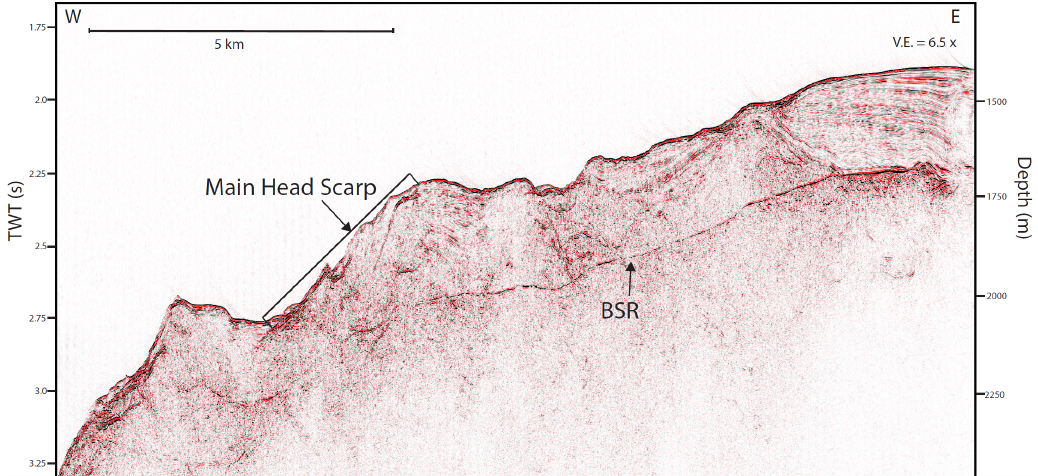
Figure 3. ( A ) Eastern half of seismic line 15 from RR1718 uninterpreted. ( B ) Eastern half of seismic line 15 interpreted. Green lines represent reverse faults and gray vertical dotted lines indicate fluid pathways. Horizontal dashed lines represent inferred layers and boundaries. The base of the landslide blocks is also an inferred boundary. ( C ) Map view of area containing the eastern half of seismic line 15. Bathymetry created using the Global Multi-Resolution Topography (GMRT) database from http://www.geomapapp.org [20].